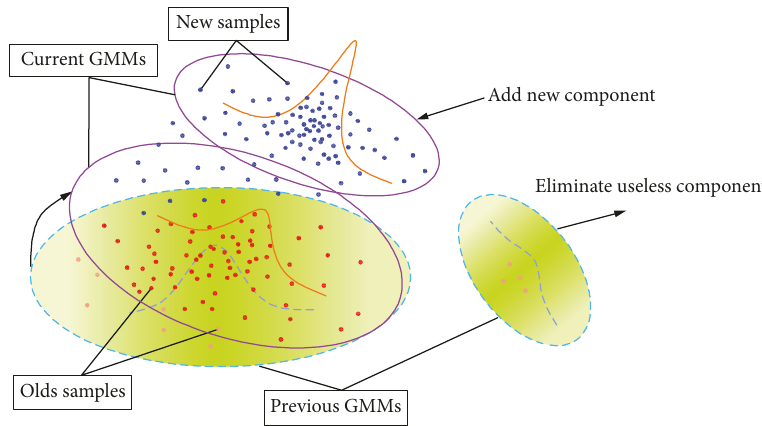
Figure 4: The schematic diagram of GMM’s online updating process.